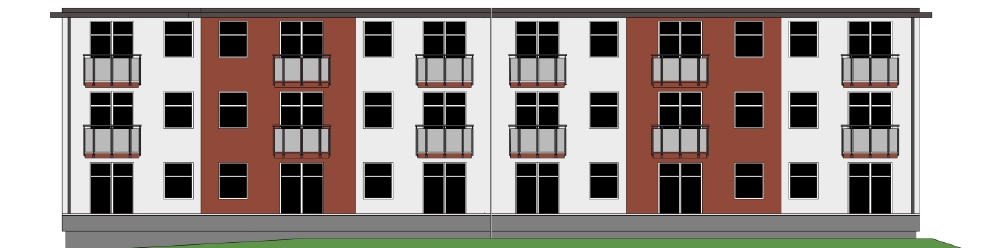
Figure 2. Elevation of the building.